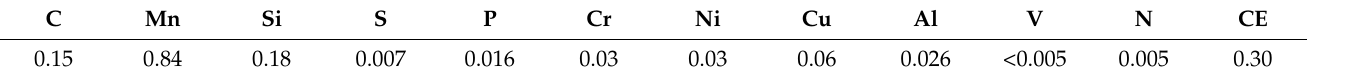
Table 2. Chemical composition (%) of the S275JR+N.